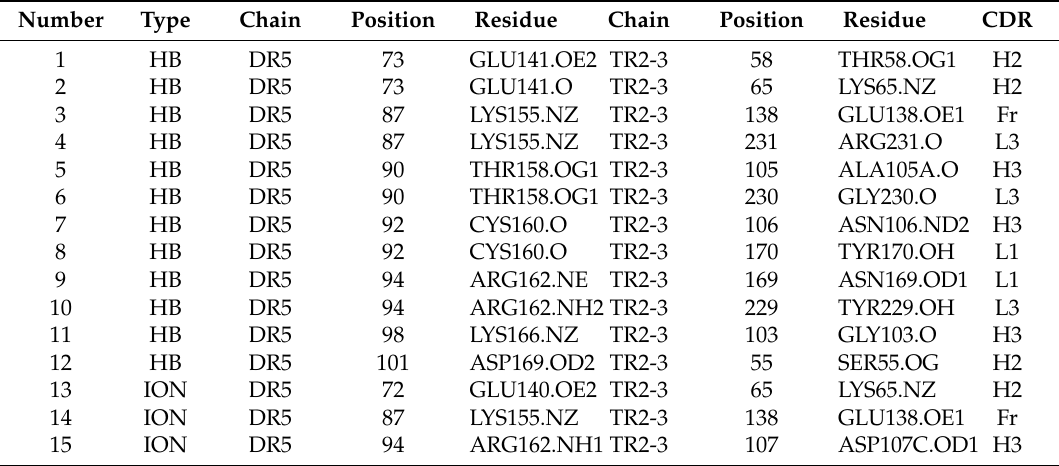
Table 3. Protein contacts between DR5 and TR2-3.